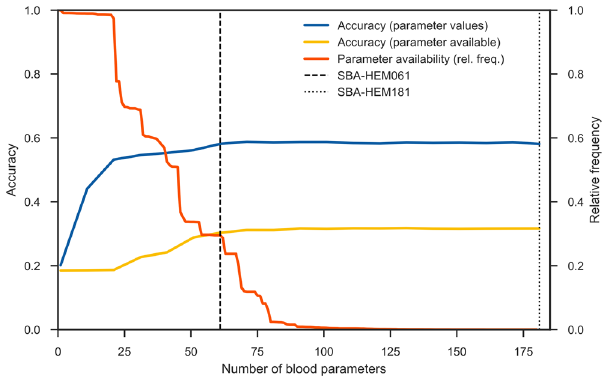
Figure 5. Influences of parameter frequency, presence and actual measured values on model accuracy. The actual parameter value (blue line) and its presence (whether it was measured or not (in yellow line) are depicted, as well as relative frequency of the parameters (the ratio of how many times they were measured to the total number of measurements in orange line). To obtain the blue accuracy curve, the actual parameter values were used for training and testing, while for the yellow accuracy curve, the parameter values were replaced with either 0 (not measured) and 1 (measured), and no imputation was used. The flattening of both accuracy curves indicates that, when the frequently measured parameters are present, the rarely measured parameters contribute little to model